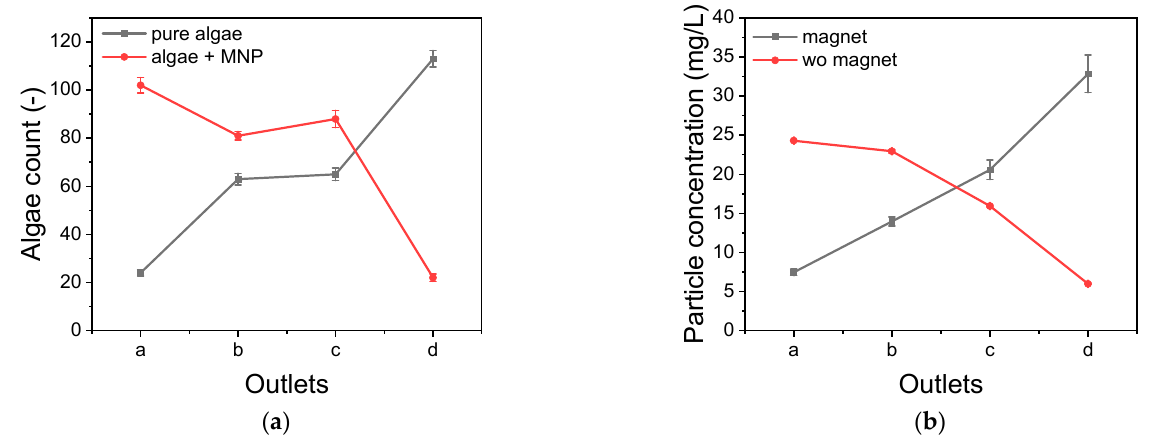
Figure 7. Separation process in millifluidic chamber 1. ( a ) Algae count from the Neubauer counting chamber for algae and mixtures of algae and magnetic nanoparticles. ( b ) Magnetic particle concentration determined with phenanthroline assay for separation with and without (wo) magnet.